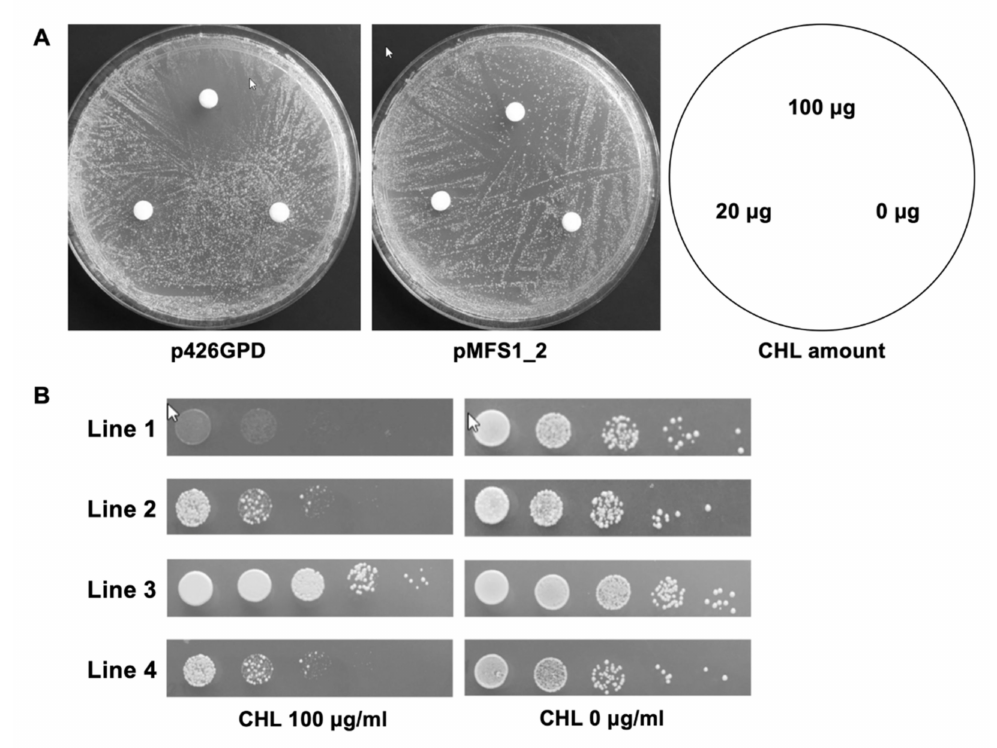
Figure 3. Resistance of S. cerevisiae overexpressing TruMFS1 to CHL. ( A ): Disc tests: S. cerevisiae Y02409 p426GPD and pMFS1-2 transformants. ( B ): Serial dilution tests. Line 1: S. cerevisiae Y02409 p426GPD transformants. Line 2: S. cerevisiae pMFS1-2 transformants. Line 3: Yeasts from growing colonies in Line 2 were resuspended in PBS, and subsequently deposited on YCAG containing CHL. Line 4: Yeasts from the growing colonies of line 2 were cultured on MMD, then the yeast cells from generated colonies were inoculated on YCAG containing